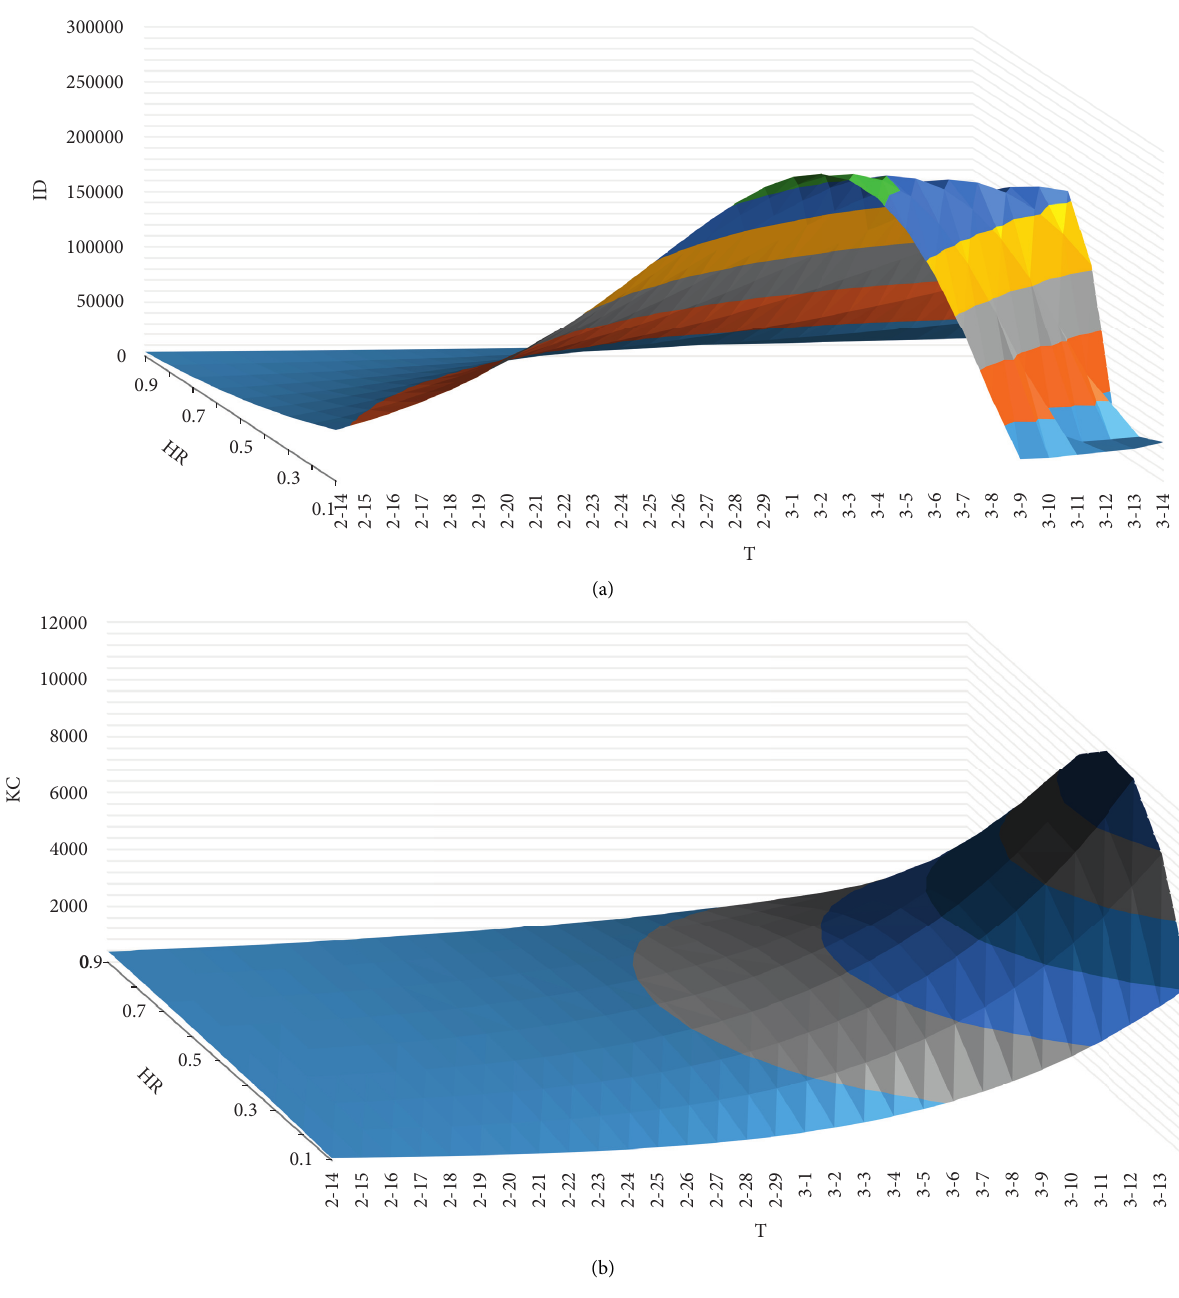
Figure 9: Trend of ID and KC under different